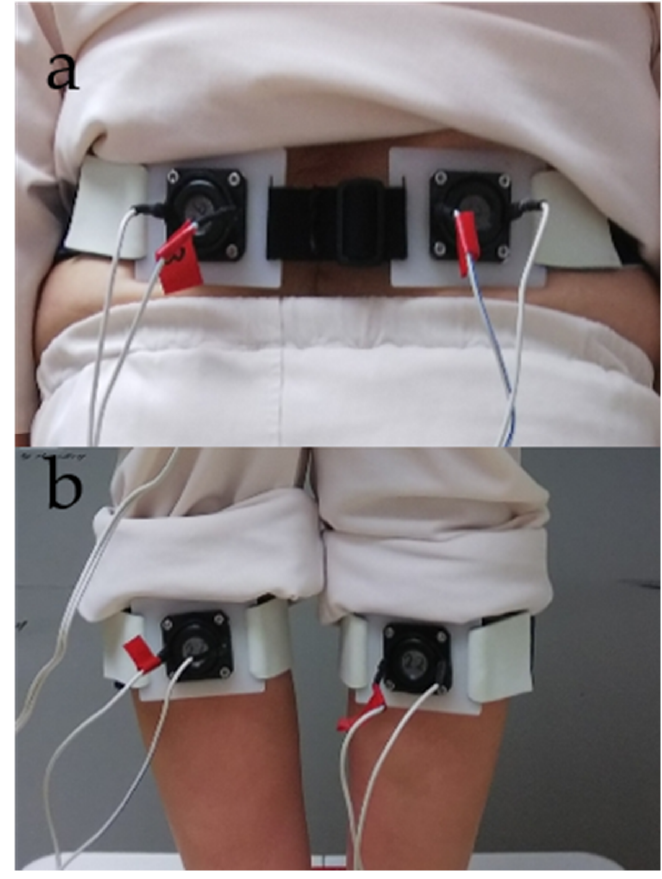
Figure 1. Vibration device setup. ( a ) Lumbar multifidus (LM). ( b ) Gastrocnemius and soleus (GS)